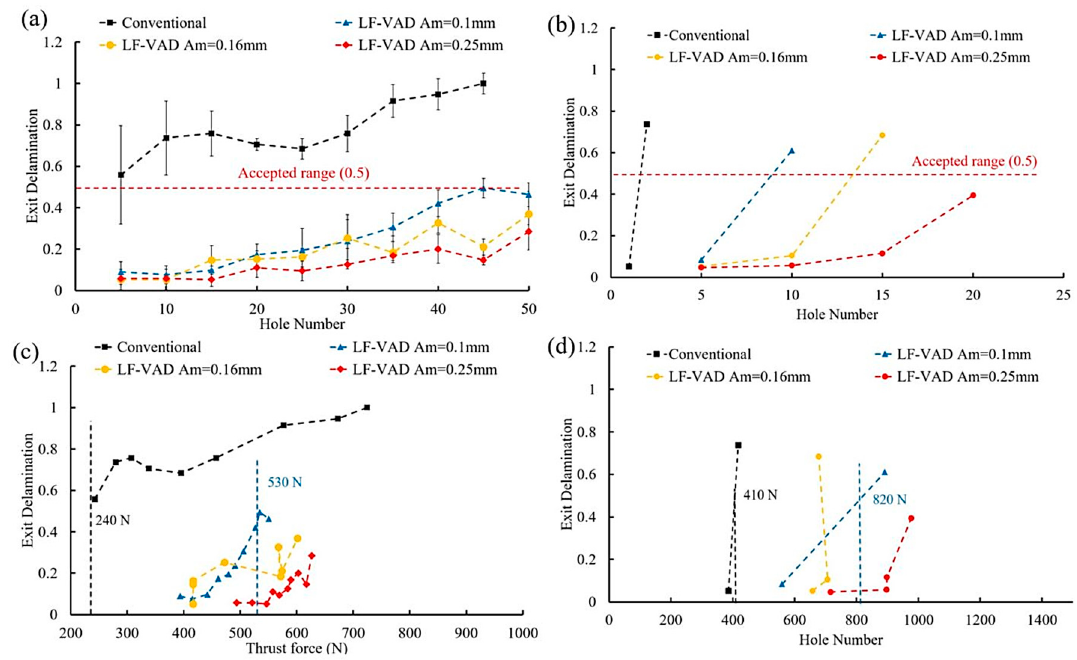
Figure 19. The effect of tool wear progress on the exit delamination and correlated thrust force at N = 56.52 m/min for ( a , c ) f = 0.025 mm/rev and ( b , d ) f = 0.075 mm/rev.